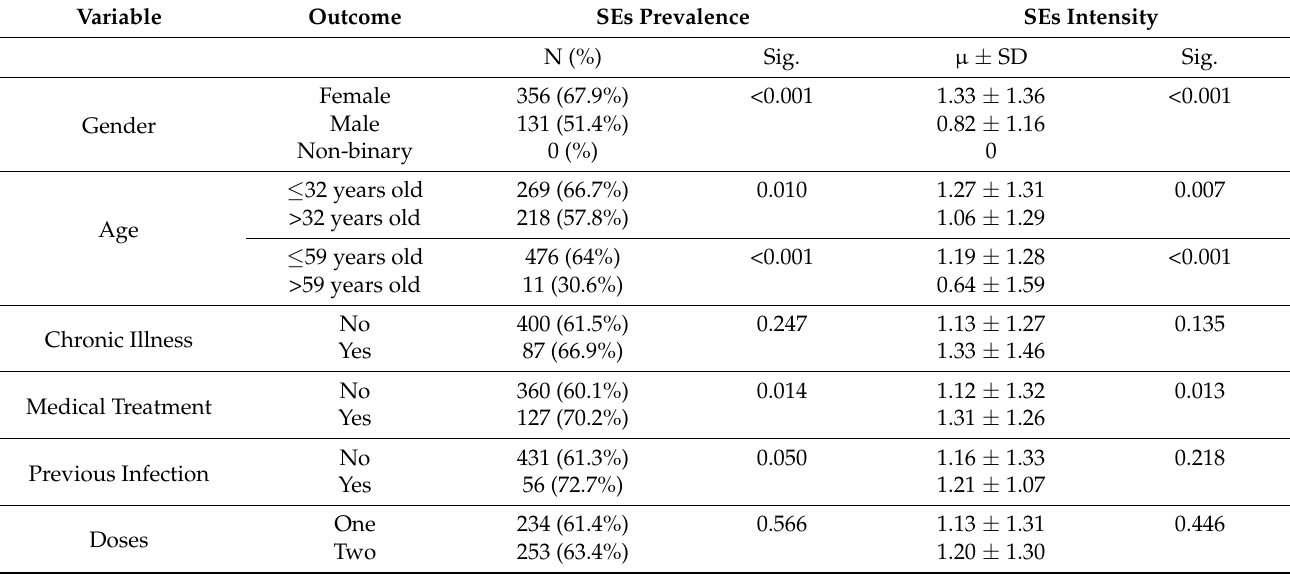
Table 5. Risk factors of CoronaVac general side effects reported by Turkish healthcare workers, from January–February 2021.